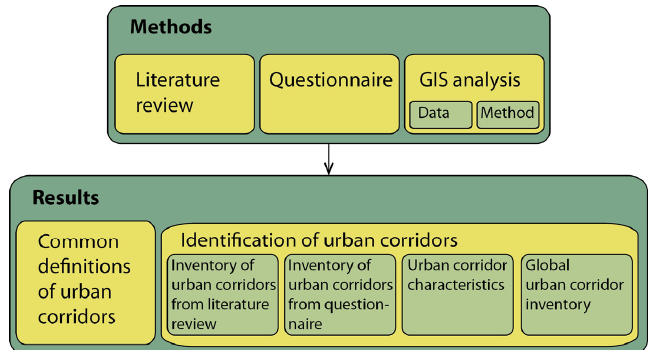
Figure 1. Methodological steps of the paper.